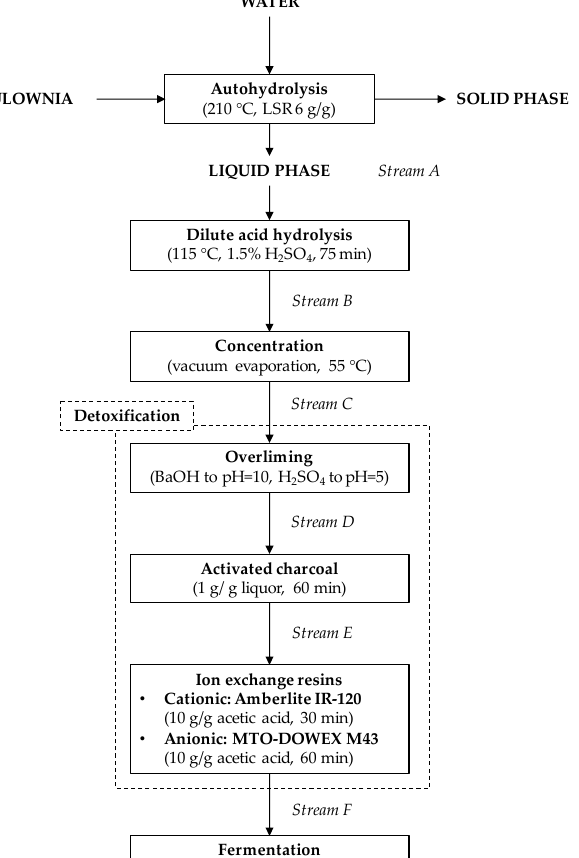
Figure 1. Flowchart of main processing steps to obtain a xylose-enriched stream derived from hemicellulosic fraction.